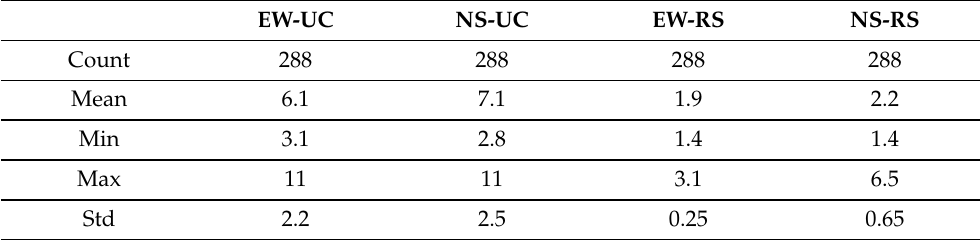
PDOP statistical analysis for GNSS + five 5G stations in case of ToA processing (EW = east-west; NS = north-south; UC = urban canyon; RS = residential